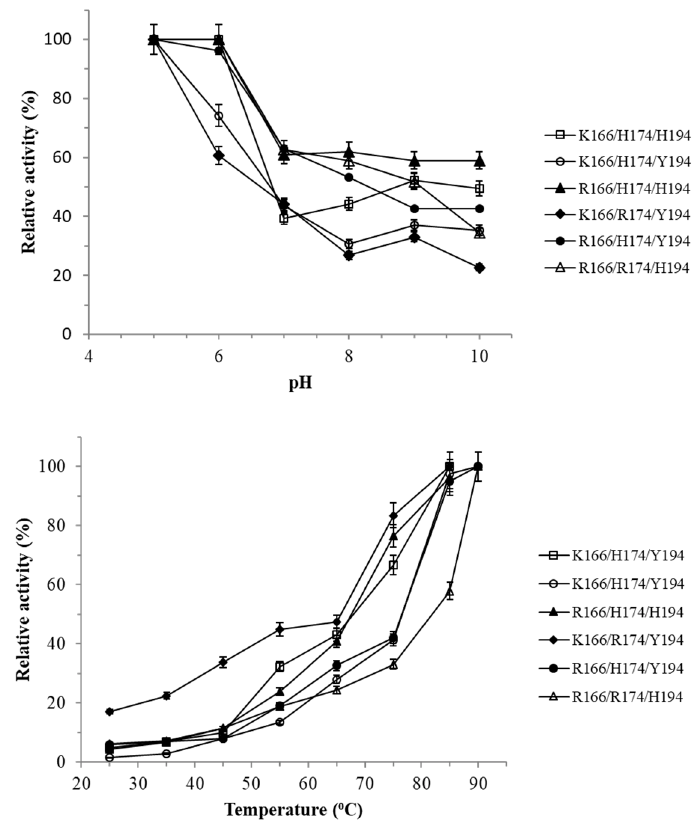
Figure 4. ( a ) The optimal pH of Tt27-NOX variants. The experiments were carried out under FMN-saturating conditions (150 µ M), 25 ◦ C, and 0.25 mM NADH. Enzymatic activity determined in pH 5 (sodium acetate 0.1 M); pH 6 (sodium citrate 0.1 M); pH 7 and pH 8 (sodium phosphate 0.1 M); pH 9 and 10 (sodium carbonate 100 mM). Symbols: ( (cid:3) ) K166 / H174 / H194 variant; ( ) K166 / H174 / Y194 variant; ( (cid:78) ) R166 / H174 / H194 variant; ( (cid:95) ) K166 / R174 / Y194 variant; ( (cid:8) ) R166 / H174 / Y194 variant; and ( (cid:52) ) R166 / R174 / H194 variant. ( b ) The optimal temperatures of Tt27-NOX variants. The experiments were carried out in 10 mM sodium phosphate pH 7 under FMN-saturating conditions. Enzymatic activity determined in 10 mM sodium phosphate pH 7, 37 ◦ C, 150 µ M FMN, and 0.25 mM NADH. Symbols: ( (cid:8) ) R166 / H174 / Y194 variant; ( (cid:78) ) R166 / H174 / H194 variant; ( (cid:3) ) K166 / H174 / H194 variant; ( (cid:95) ) K166 / H174 / Y194 variant; ( ) K166 / R174 / Y194 variant; and ( (cid:52) ) R166 / R174 / H194 variant.